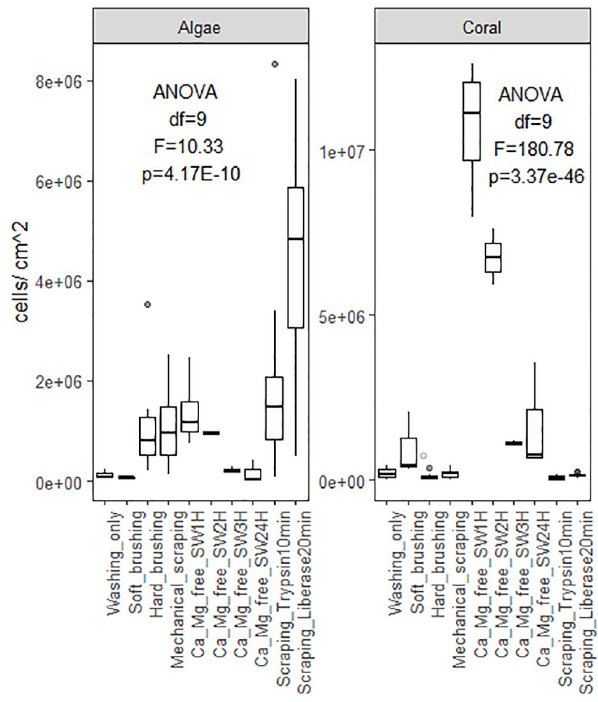
Fig 1. Cell yields according to dissociation method. Average algae cell (left) and coral cell (right) yields as a factor of dissociation method (washing, soft/hard brushing, mechanical scraping, or calcium-magnesium-free seawater incubation for 1 to 24 hours) and enzyme digestion (Trypsin or Liberase), S1 Table. [ANOVA single factor: Algae df = 9, F = 10.33, p = 4.17E-10; Coral df = 9, F = 180.78, p =